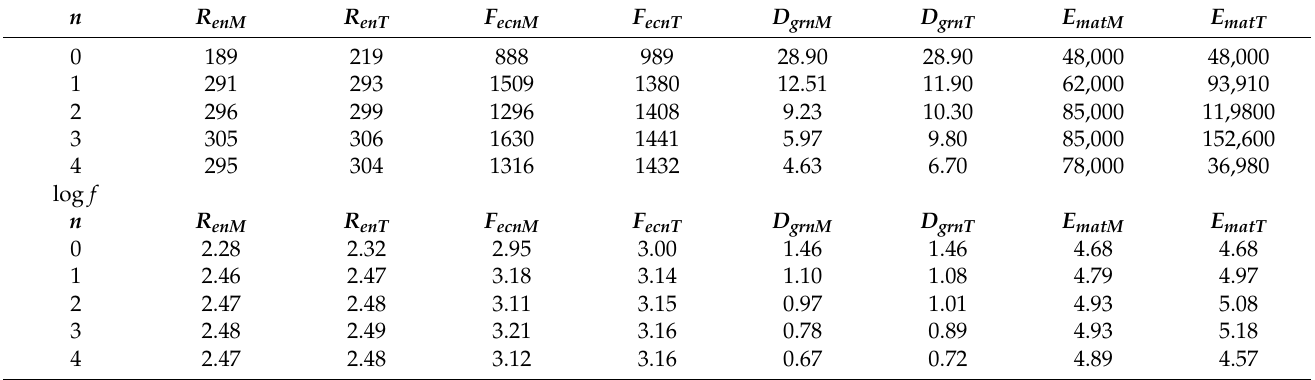
Table 3. Comparison of measured and theoretical